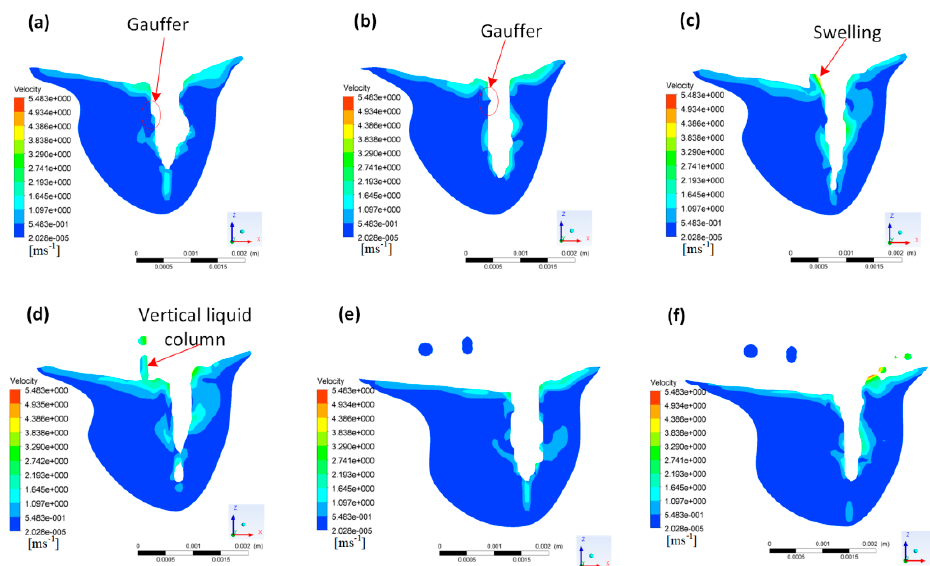
Figure 9. Velocity contour of the molten pool when the welding speed was 3 m/min: ( a ) t = 24 ms, ( b ) t = 25 ms, ( c ) t = 28.5 ms, ( d ) t = 28.8 ms, ( e ) t = 46.3 ms, ( f ) t = 46.8 ms.